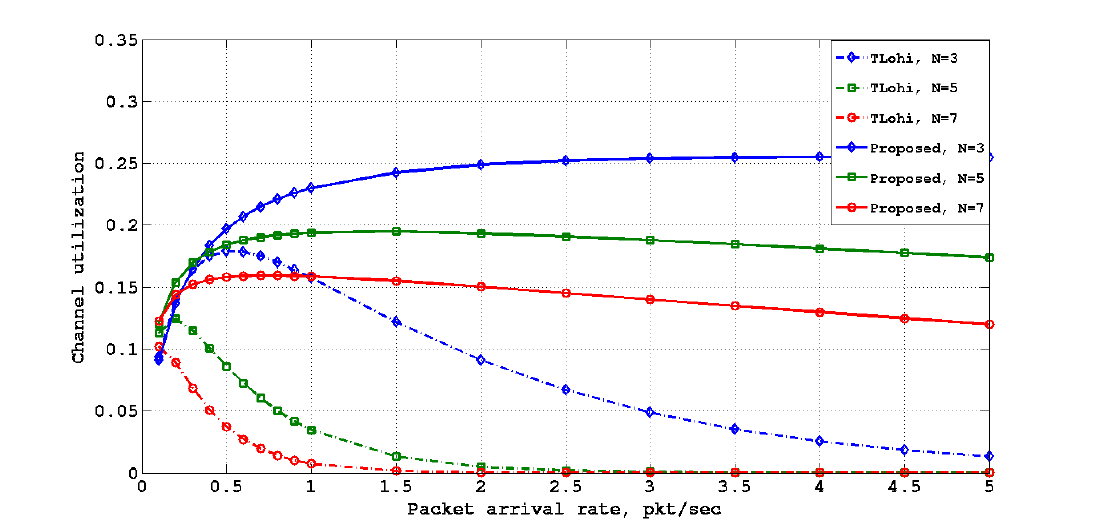
Figure 5. Channel utilization vs. packet arrival rate.